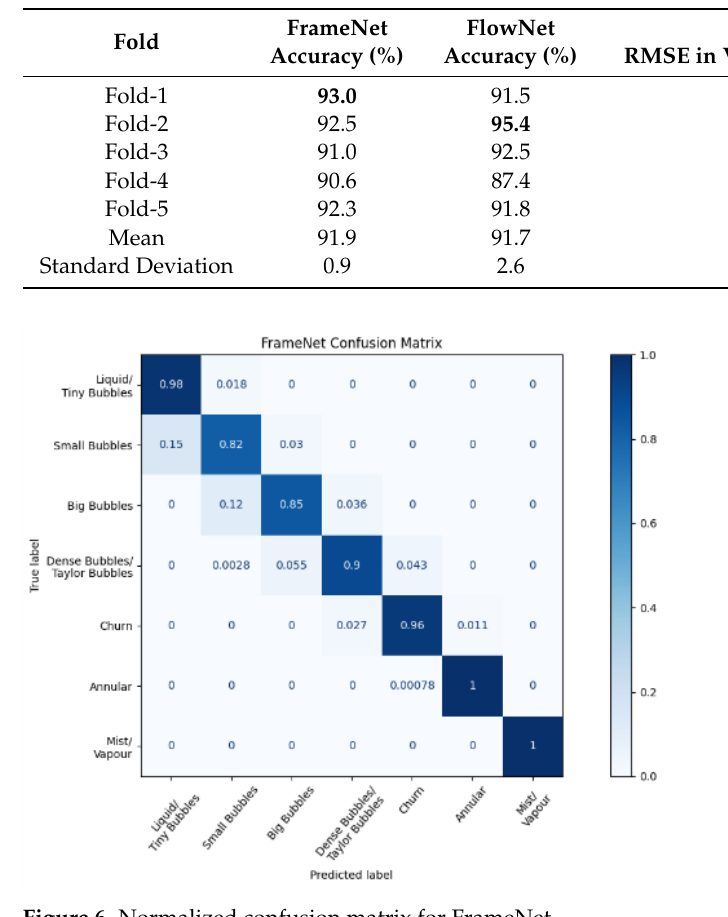
Figure 7. Normalized confusion matrices for FlowNet: ( a ) during offline testing; ( b ) during online testing using the experimental prototype.